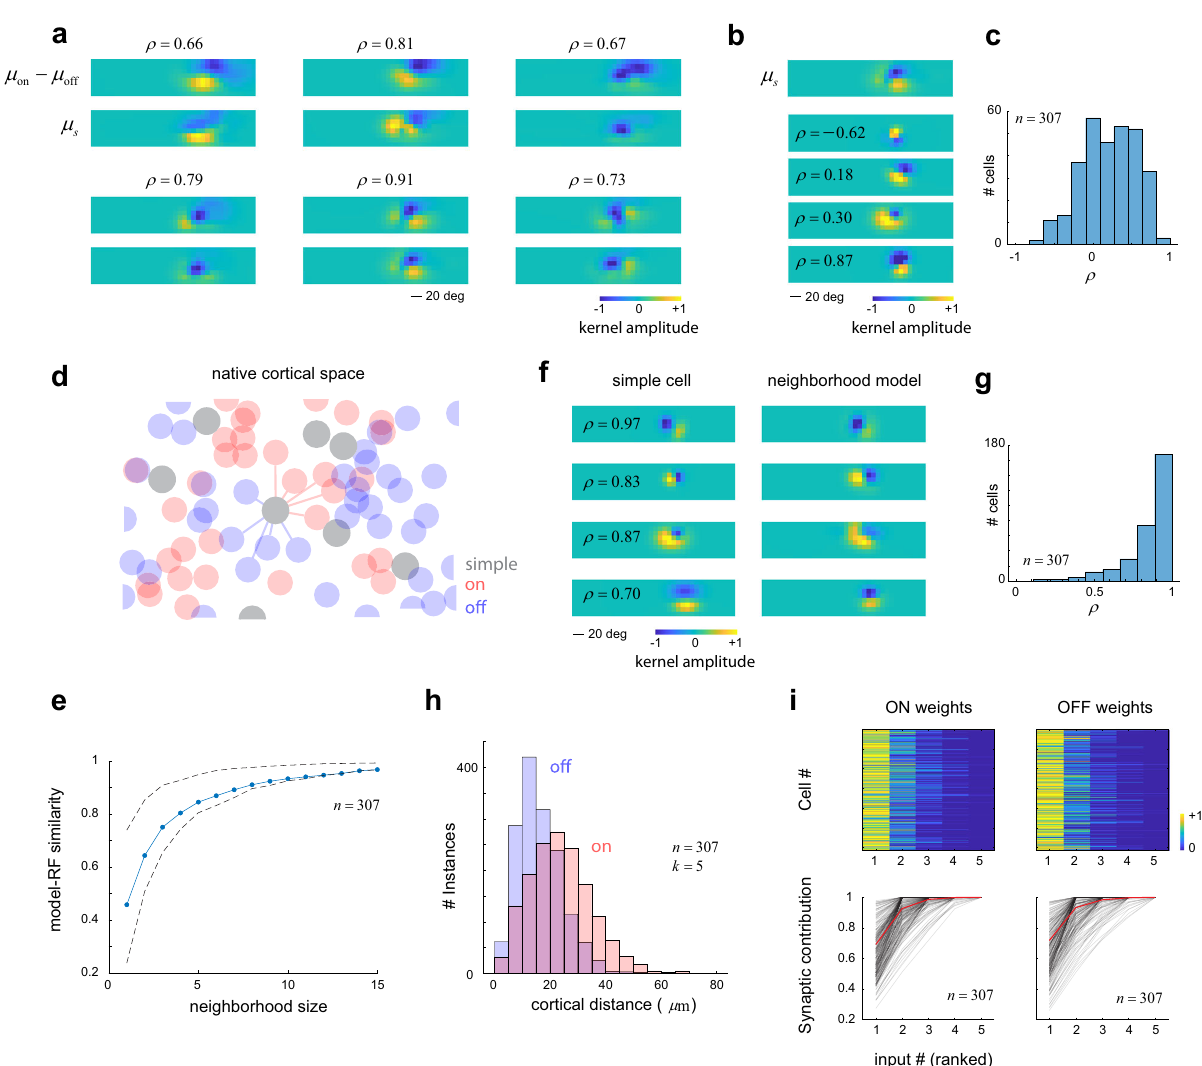
Fig. 6 ON/OFF domains shape receptive fi eld structure. a Correlation between ON/OFF and simple-cell receptive fi elds. Each panel displays the result of one experiment. The top row displays the difference between the average ON ( μ on ) and OFF ( μ off ) receptive fi elds in the population, while the bottom row shows the average of all simple-cell receptive fi elds ( μ s). The two are correlated ( p < 0.001 in all cases). b Diversity of receptive fi elds in the population, showing the average along with the receptive fi elds of individual cells and their correlation coef fi cient with respect to the average. c Distribution of correlation coef fi cients between μ s and those of individual cells in one experiment. d Modeling simple-cell receptive fi elds as linear combination of ON and OFF signals in a local neighborhood. The diagram shows a cartoon of a top view of a cortical patch of V1. ON and OFF cells de fi ne domains where one representation is dominant. Simple cells are assumed to pool ON and OFF signals within their neighborhood. e Model performance as a function of neighborhood size. Performance starts to saturate at a neighborhood size of k ~5. Dashed lines indicate 25th and 75th percentiles of the distribution of correlation coef fi cients for each neighborhood size). f Example of four model fi ts. g Model performance for all neurons in one experiment for k = 5 showing the distribution of correlation coef fi cients between the actual receptive fi elds and their approximation by the model. h Distribution of distances for ON and OFF from simple cells for a neighborhood size of fi ve — most cells are within 50 μ m of the target neuron. ON cells are statistically more distant than OFF cells ( p ¼ 1 : 210 (cid:2) 18 , rank sum test). i ,- Distribution of weights for ON and OFF neurons in decreasing order by rank (top). Weights are normalized by their total contribution. Two ON or OFF cells are suf fi cient to account for 90% of the total synaptic input to the neuron, as shown by the average cumulative distribution (bottom, red curve; individual cells shown by black curves). This dataset had n on ¼ 379, n off ¼ 895 and n on þ off ¼ 307 cells (corresponding to dataset #7 in Table 1). Source data provided for panels c , e , g , h , i